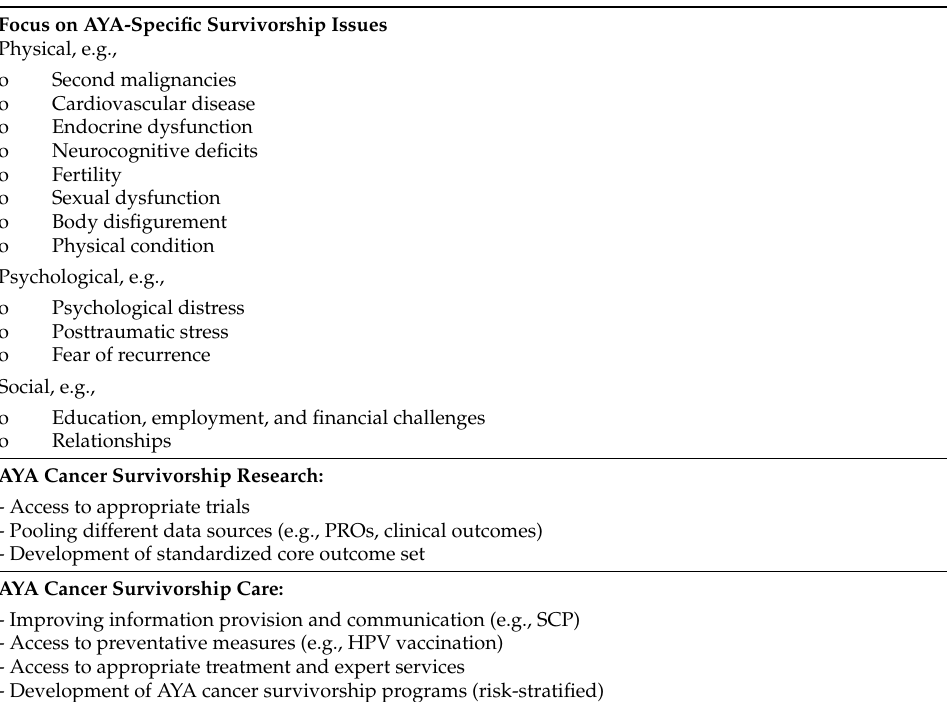
Table 2. Key points of AYA-specific